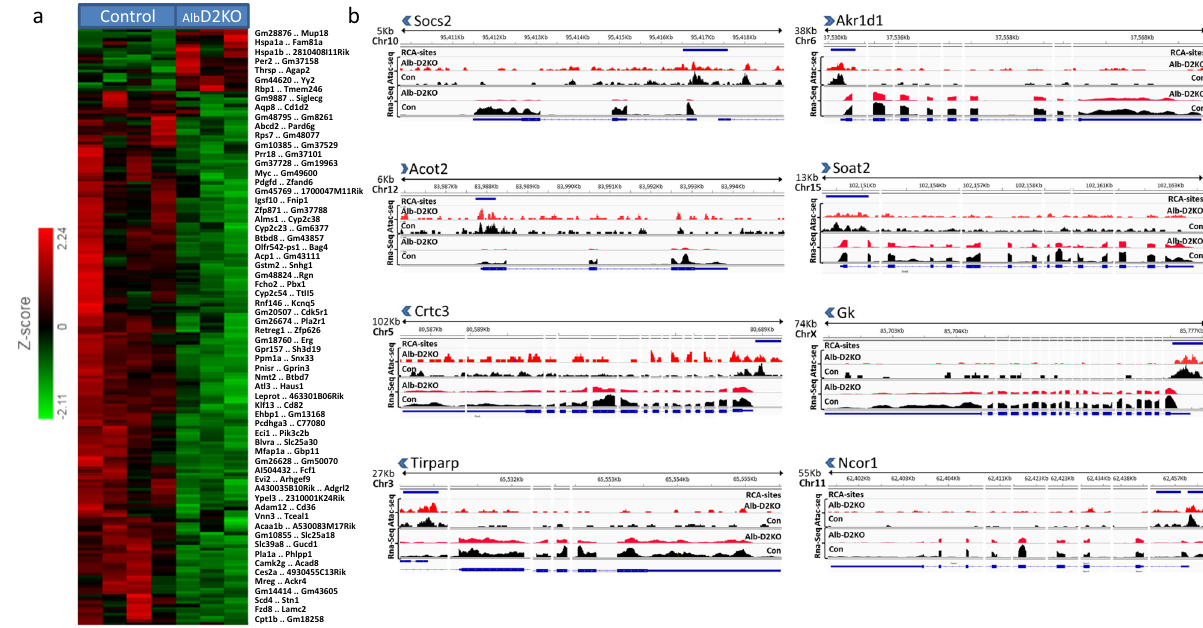
Fig. 3 Gene expression in the ALB-D2KO mouse liver. a heat-map of liver RNA-seq data showing clustering of genes affected in the ALB-D2KO mouse; green indicates relative down-regulation; red indicates relative upregulation; fold change is shown on the left; most gene names are indicated on the right (nine samples were studied with no further replication); b browser IGV display of transcript areas of selected genes (eight representative genes out of a total of 146 genes) that are downregulated in the Alb-D2KO liver AND exhibit a RCA area within its core promoter region; the distance between the negative RNA-seq peak and the RCA area in all cases is < 5 Kbp; the gene names are indicated on the top of each panel along with the arrow indicating direction of transcription; the red tracks re fl ects the coverage for the Alb-D2KO Atac-seq and RNA-seq data, and the black tracks re fl ects the controls; the statistically signi fi cant RCA areas are indicated by a blue